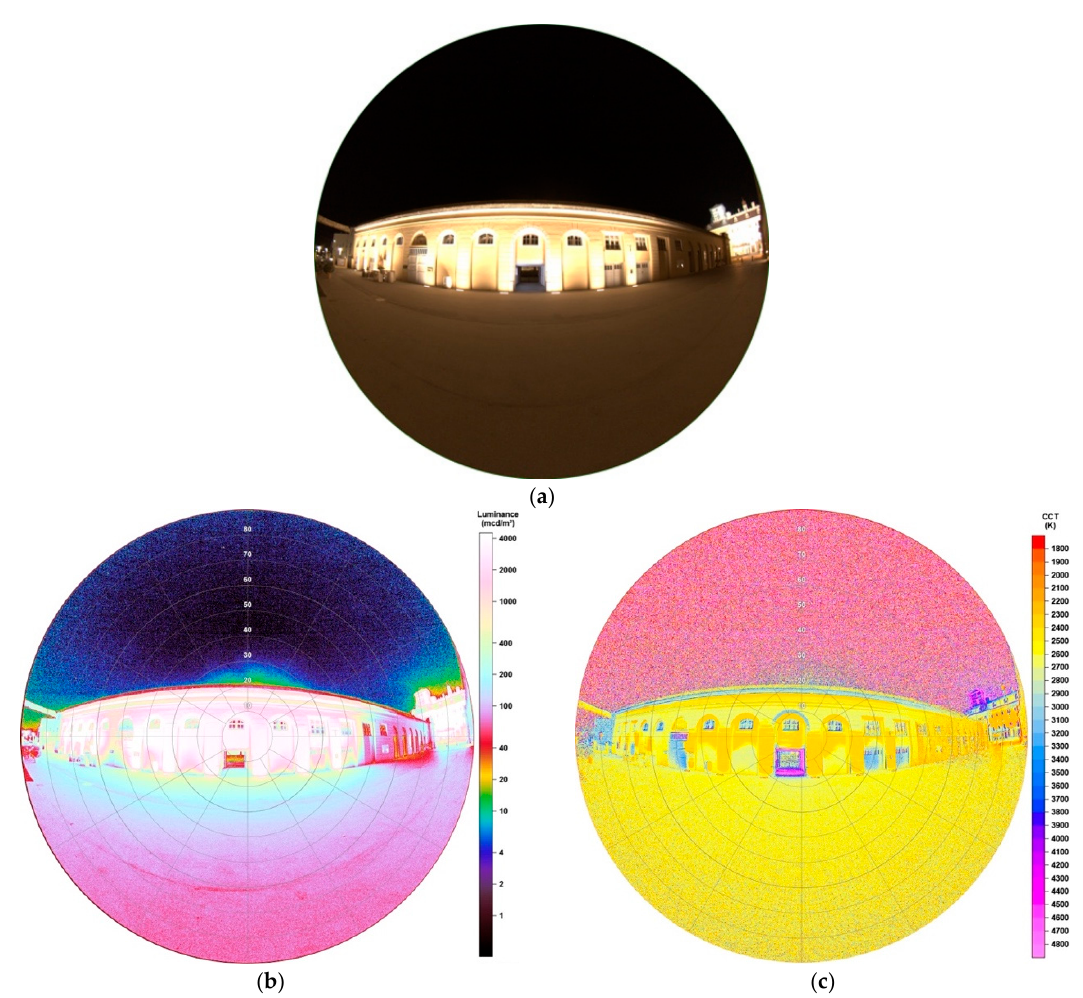
Figure 13. ( a ) Image of the illuminated Market Hall during night-time, taken with fisheye lens for detailed analysis (date: 29.07.2019, 23:24 h; exposure time: 0.4 s); ( b ) Luminance matrix as displayed by SQC; ( c ) CCT matrix as displayed by SQC.